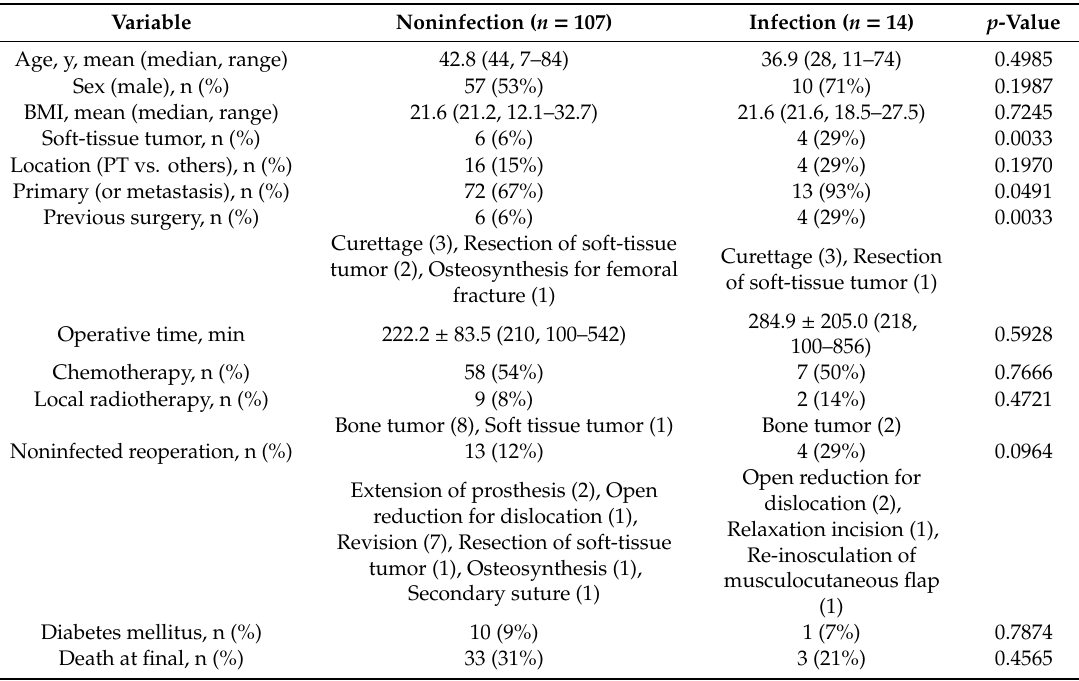
Table 3. Univariate analysis of the factors at baseline.